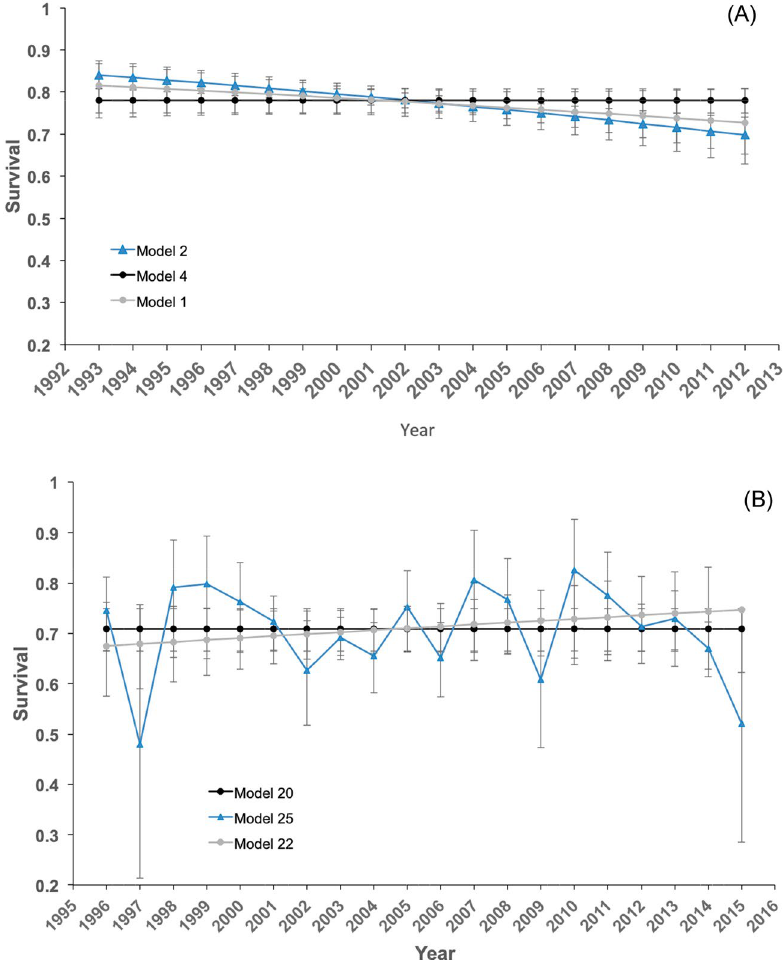
Figure 3. Changes in the annual survival probabilities of leatherback turtles (Mean and 95% CI) from the selected models in ( A ) Costa Rica (model 1 in grey, model 2 in blue and model 4 in black; Supplementary Table 1) and ( B ) México (Model 20, in black, model 22 in grey, and model 25 in blue; Supplementary Table 1). For Costa Rica survival show a decreasing trend over time in two of the best models and is constant in the other one. For México best models cannot disentangle whether survival is affected by Winter MEI, is constant, or show an increasing trend over